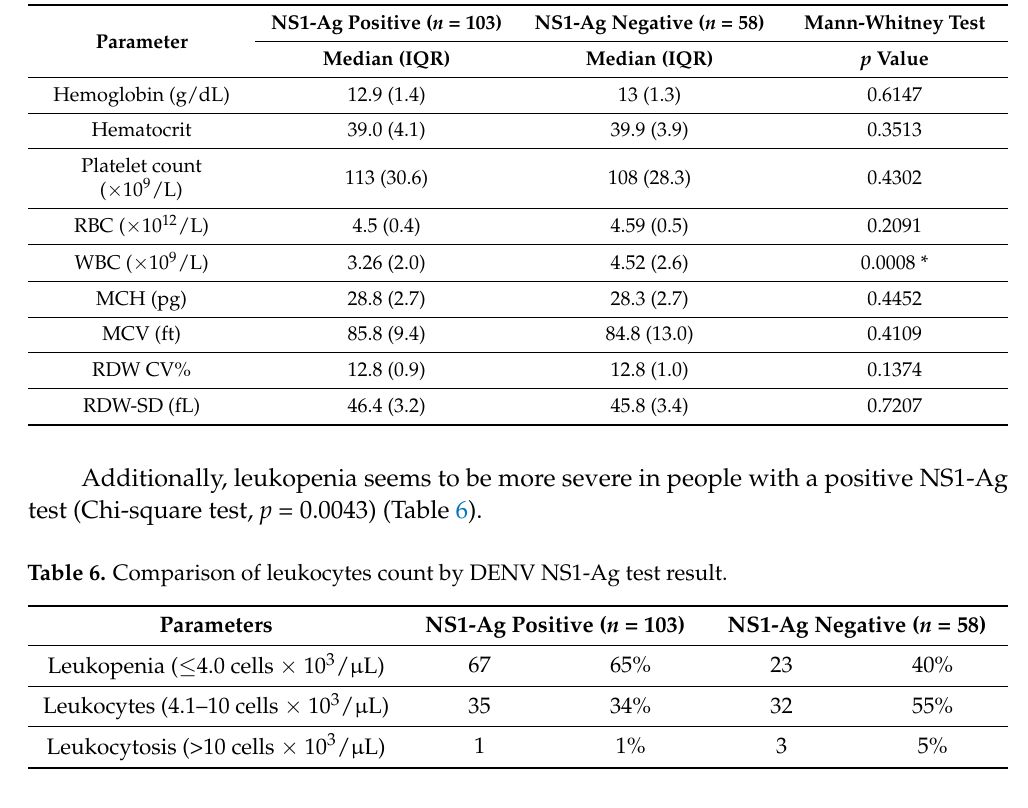
Table 5. Hematological findings between people with positive and negative DENV-NS1-Ag tests. (*) indicate significant by Mann-Whitney test.